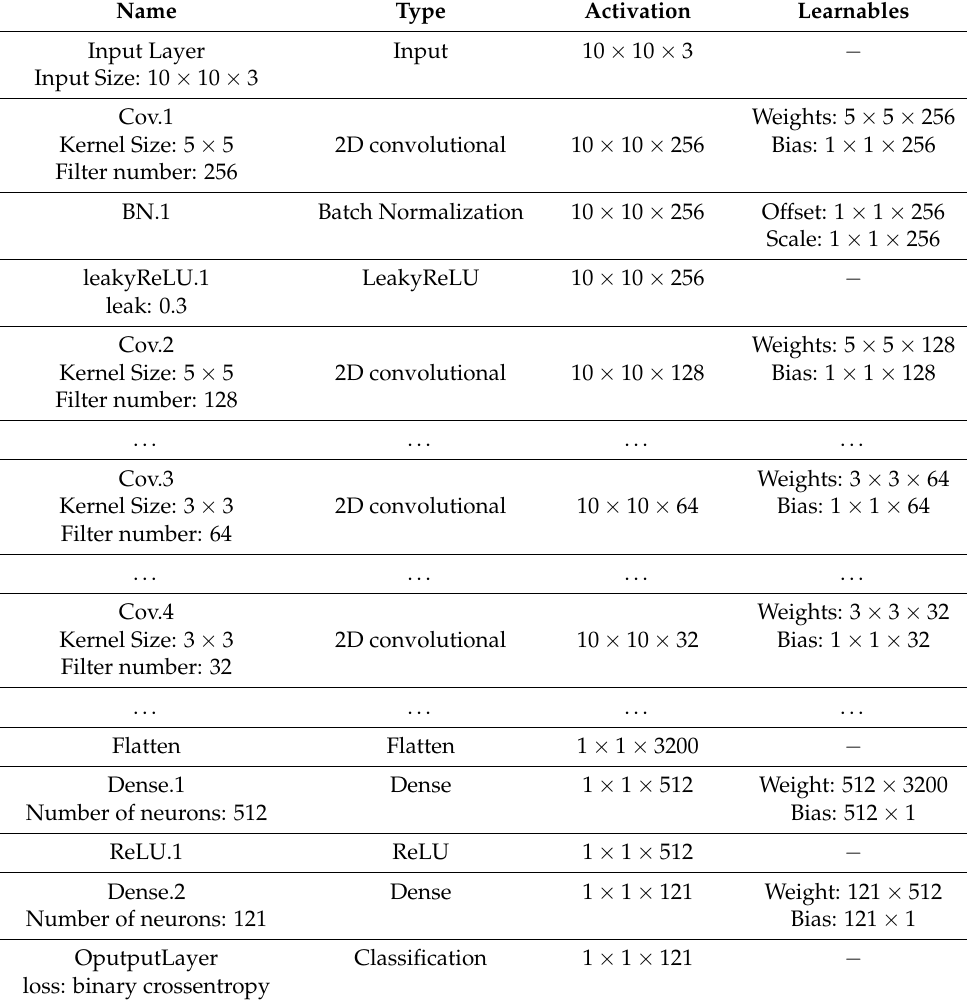
Table 2. Parameters of second-stage fine DOA estimation network